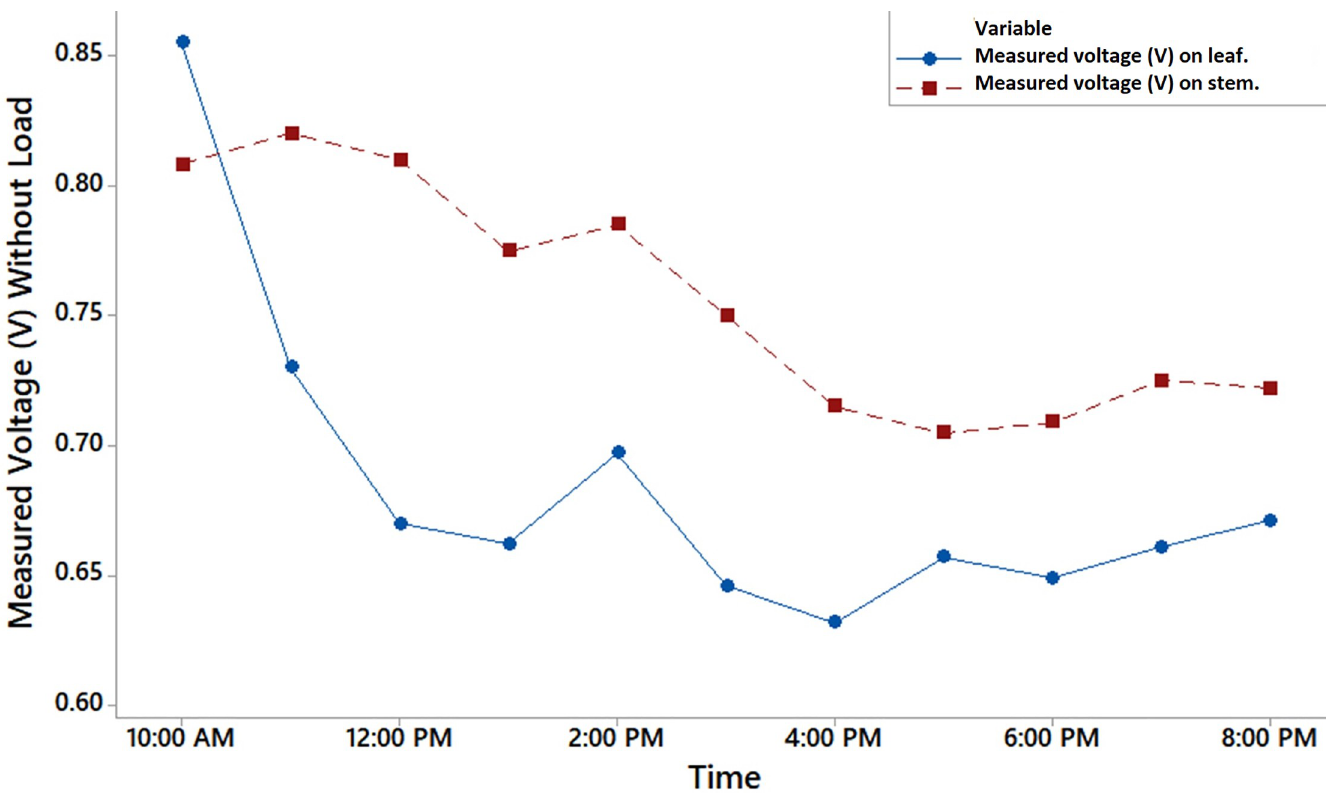
Fig 16. Comparison of voltage harvested from Aloe Vera leave and stem.